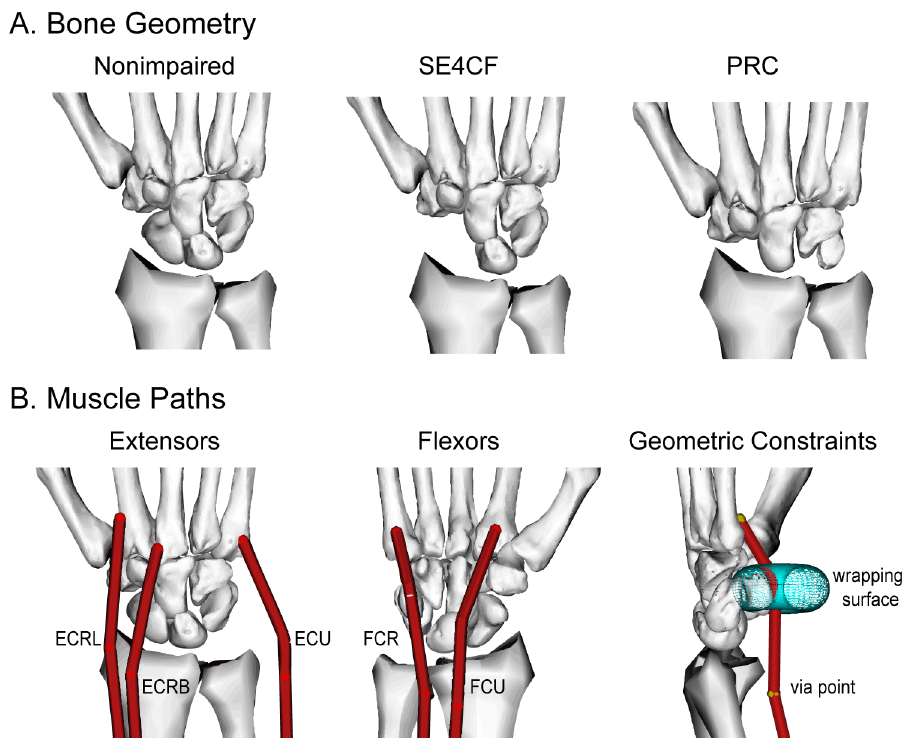
Fig 1. Wrist Models. (A) Bone geometry and (B) muscle paths implemented in the nonimpaired, SE4CF, and PRC models. Only the five primary wrist muscles were included: extensor carpi radialis longus (ECRL), extensor carpi radiali brevis (ECRB), extensor carpi ulnaris (ECU), flexor carpi radialis (FCR), and flexor carpi ulnaris (FCU). Muscle paths were constrained to anatomically realistic lines of action using via points and wrapping